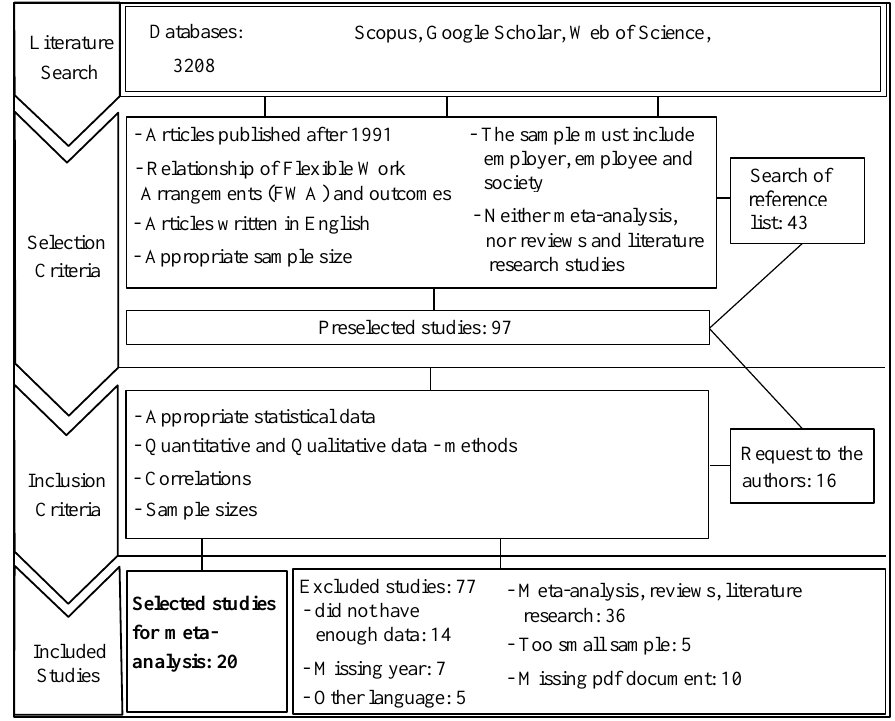
Figure 2. Schematic diagram of literature research and included